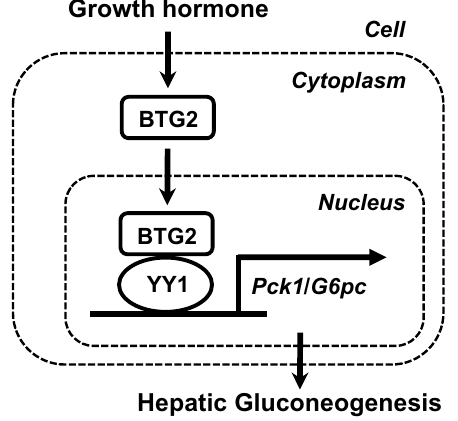
Figure 5. Proposed diagram for the regulation of hepatic gluconeogenesis by growth hormone. Growth hormone significantly increases hepatic gluconeogenesis via the upregulation of the BTG2–YY1 signaling